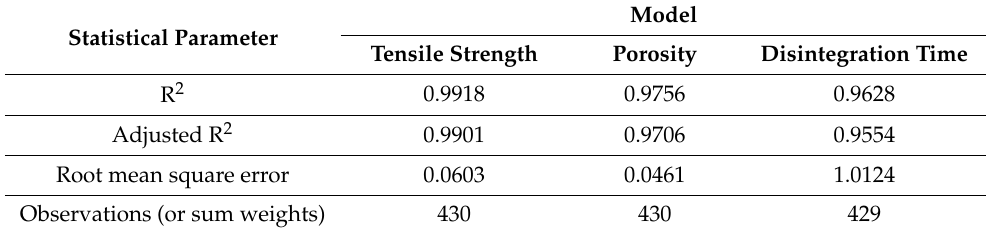
Table 3. Summary of the reduced regression models’ statistical parameters.